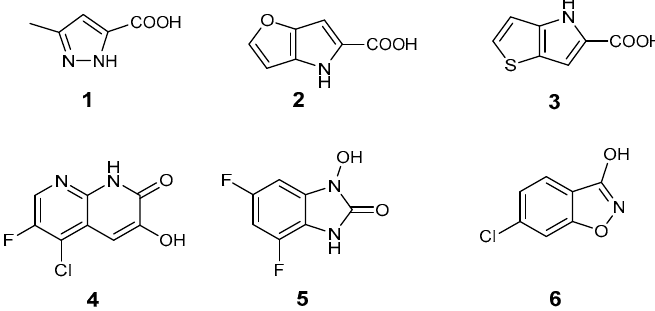
Figure 1. Known active site DAAO inhibitors in the literature.